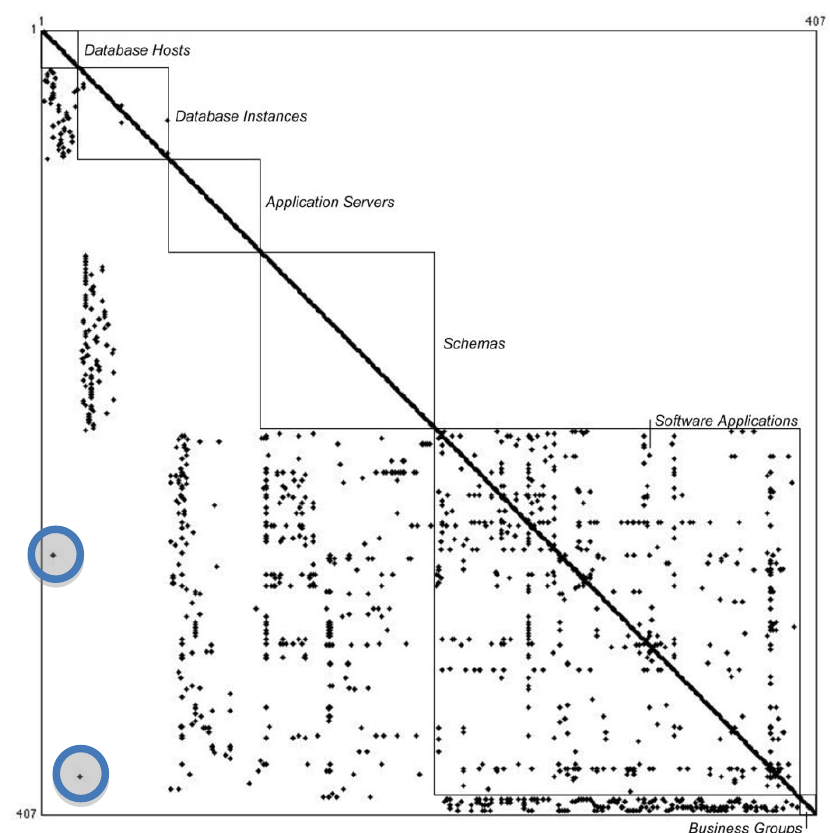
Figure 1 . A DSM displaying BioPharma’s layered Enterprise